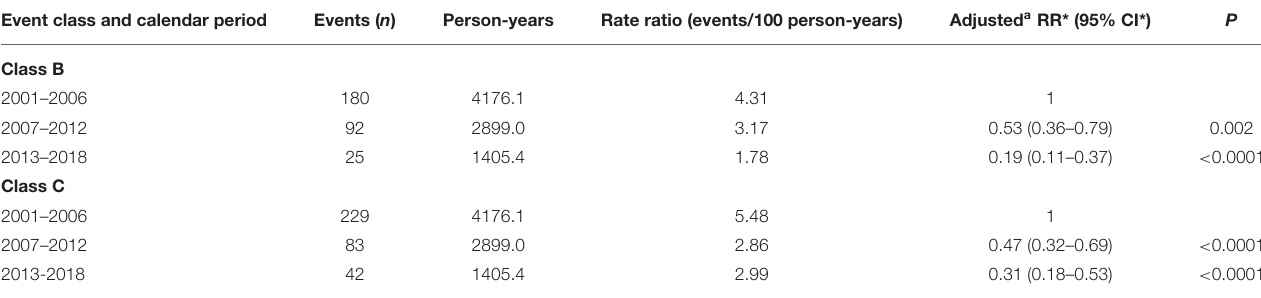
* RR, rate ratio; CI, confidence interval. a Adjusted for age and repeated events in the same